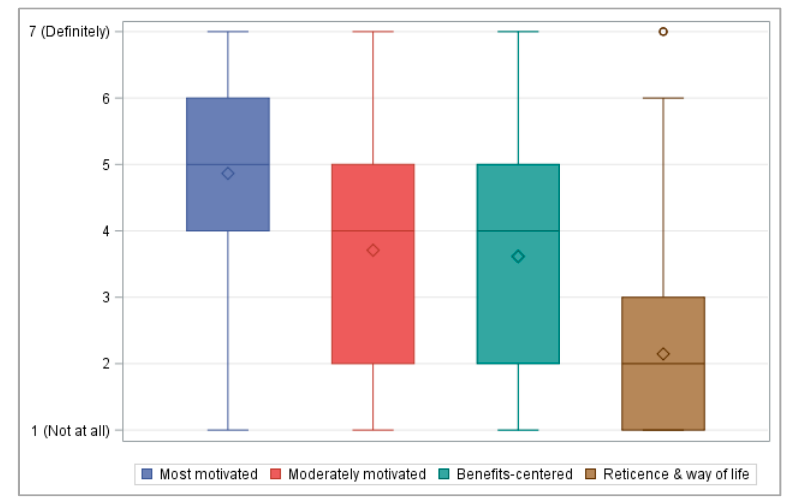
Figure A1. Respondents’ levels of agreement with the four viewpoints regarding HCRCT (ANRS- FigureA1. Respondents’levelsofagreementwiththefourviewpointsregardingHCRCT(ANRS-APSEC APSEC study, n = 164). study, n =